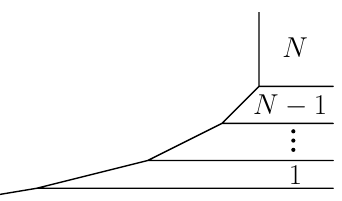
Figure 15. The web diagram associated to the b gl ( N ) Kac-Moody